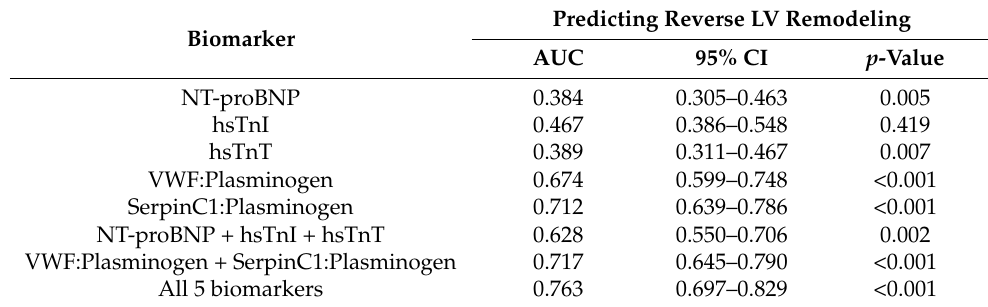
Table 4. Area under the receiver-operating curve (AUC) of different candidate markers predicting reverse LV remodeling.